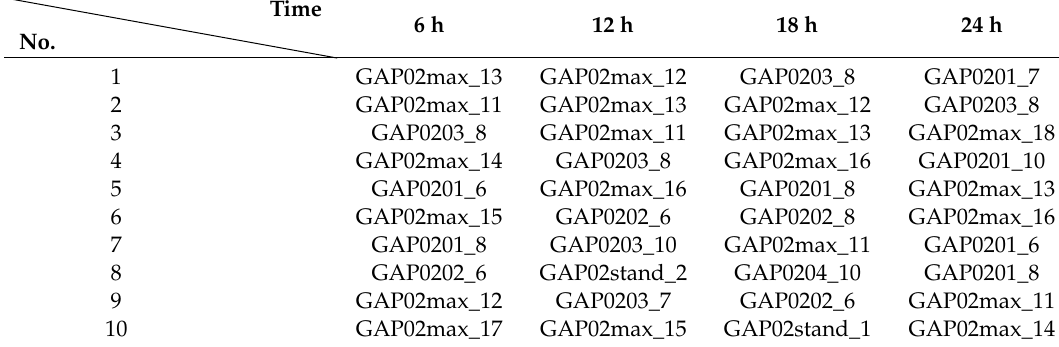
Table 6. Selected satellite factors at lead times of 6, 12, 18, and 24